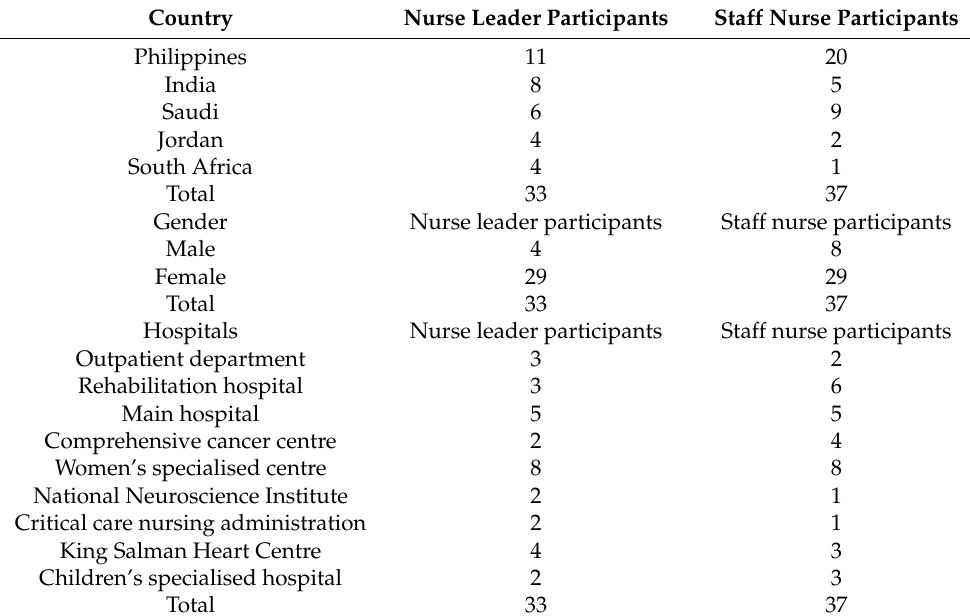
Table 2. Sociodemographic profile: qualitative